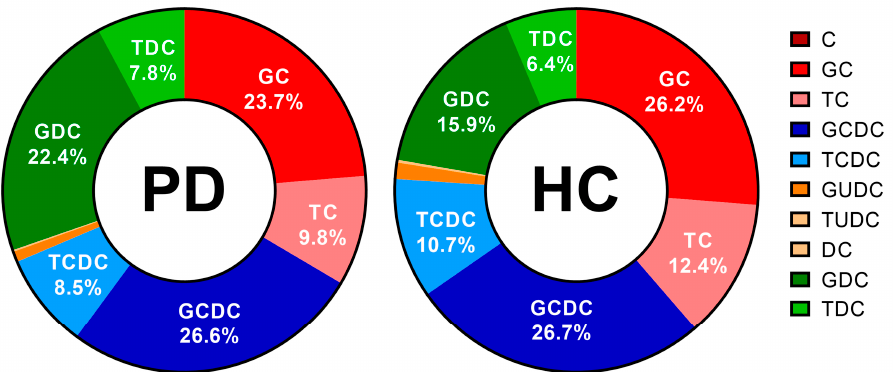
Figure 10. Relative bile salt composition in duodenal fluids aspirated from Parkinson’s disease patients (PD, n = 9, left) and healthy controls (HC, n = 9, right). Percentages as a function of the total bile salt level were calculated as the average of all time-based samples (i.e., both fasted and fed state) per patient population; percentages of the 6 most abundant bile salts are depicted in the chart. Cholic acid (C), glycocholic acid (GC), taurocholic acid (TC), chenodeoxycholic acid (CDC), glycochenodeoxycholic acid (GCDC), taurochenodeoxycholic acid (TCDC), glycoursodeoxycholic acid (GUDC), tauroursodeoxycholic acid (TUDC), deoxycholic acid (DC), glycodeoxycholic acid (GDC) and taurodeoxycholic acid (TDC).